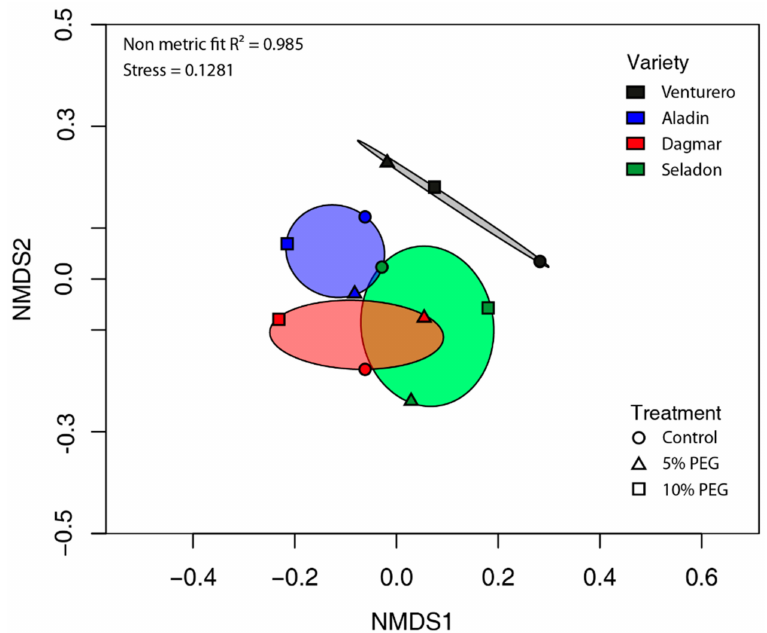
Figure 2. Non-metric multidimensional scaling (NMDS) plot for all samples at the OTU phylogenetic level based on the Bray–Curtis similarities of relative bacterial abundances of di ff erent wheat varieties cultured in vitro.